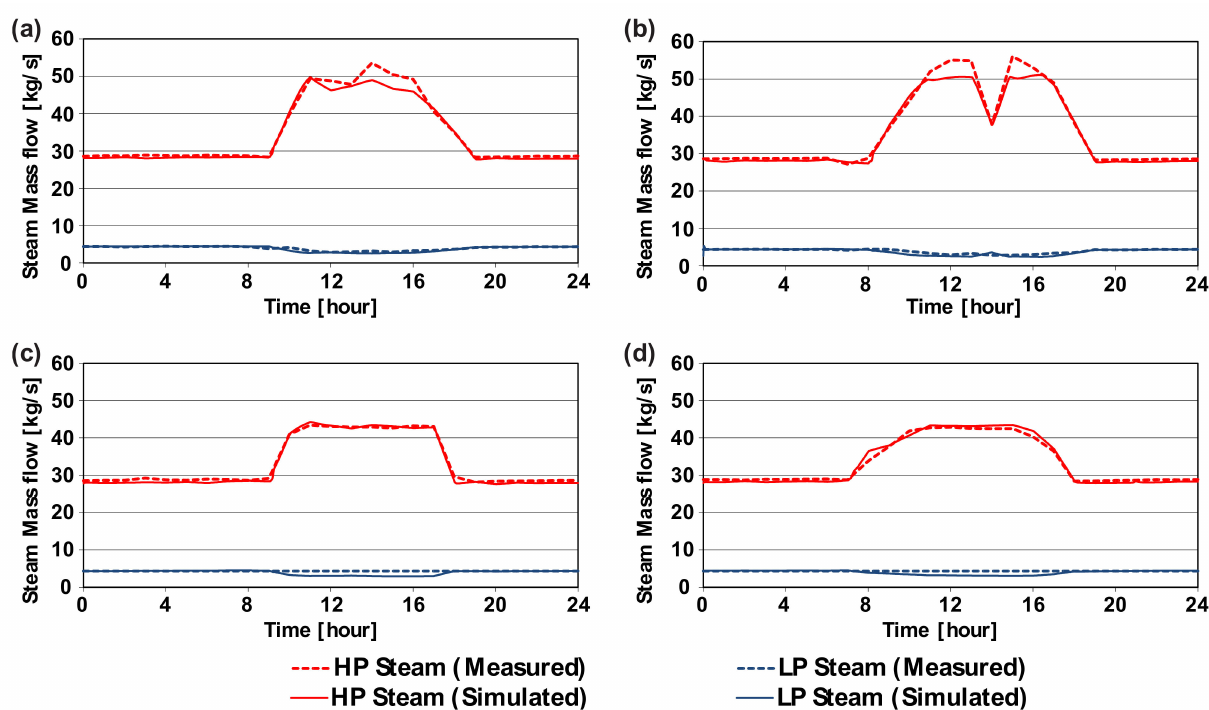
Figure 9. The steam mass flow rate for four days: ( a ) 20 July 2013; ( b ) 21 July 2013; ( c ) 30 August 2013 and ( d ) 4 September 2013.